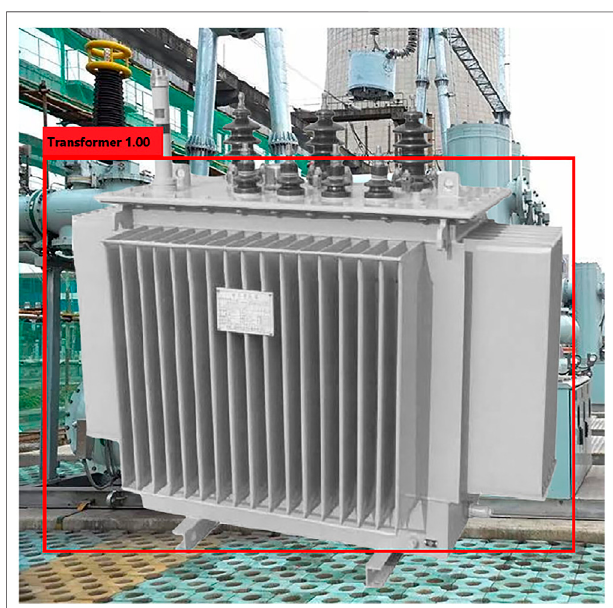
FIGURE 8 | Single image detection result of YOLOv4